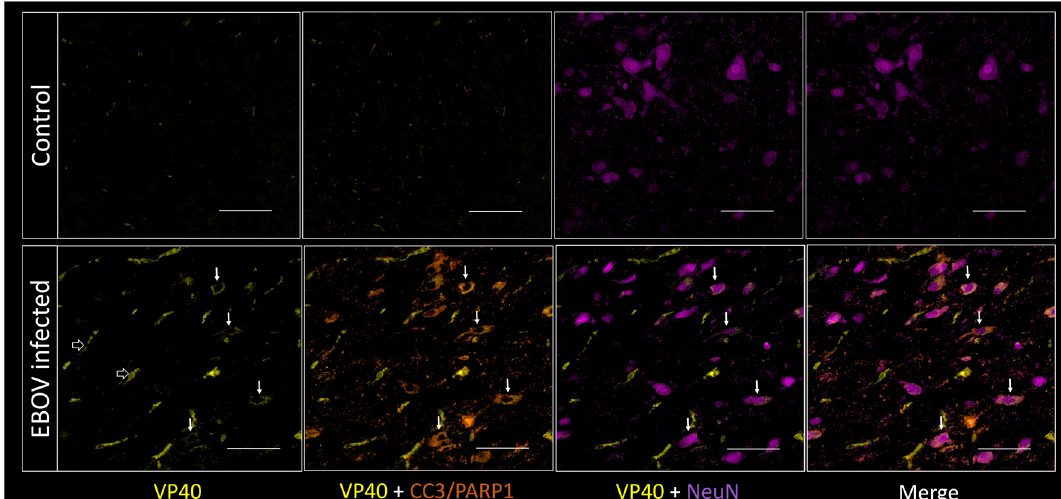
Fig. 6 Multiplex fl uorescence immunohistochemistry staining for viral antigen (VP40; yellow), apoptosis (CC3/PARP1; orange) and neurons (NeuN; purple) in the brainstem of control and infected animals. VP40 staining is seen in the vessels of the infected animal (not perfused) (white open arrows). VP40 is also overlapping with neuronal and apoptosis markers (small solid white arrows), suggesting infection and injury of multiple neurons in the fi eld of view. Staining was performed for nine infected and one control animal. Scale bar = 100 µ m, magni fi cation